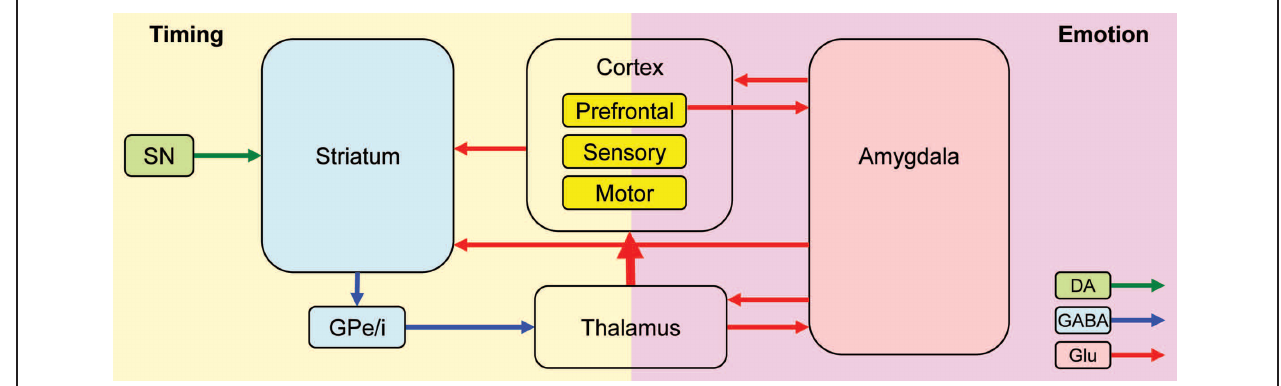
FIGURE 7 | A neurobiological RTS model: Interactions between timing and emotion circuits. Interval timing relies on fronto-striatal circuits and cortical regions involved in attention and working memory. Emotional processing relies on direct thalamo-amygdalar projections (low road), and indirect thalamo-cortico-amygdalar projections (high road). Interactions between the timing and emotion circuits may occur at cortical level, or